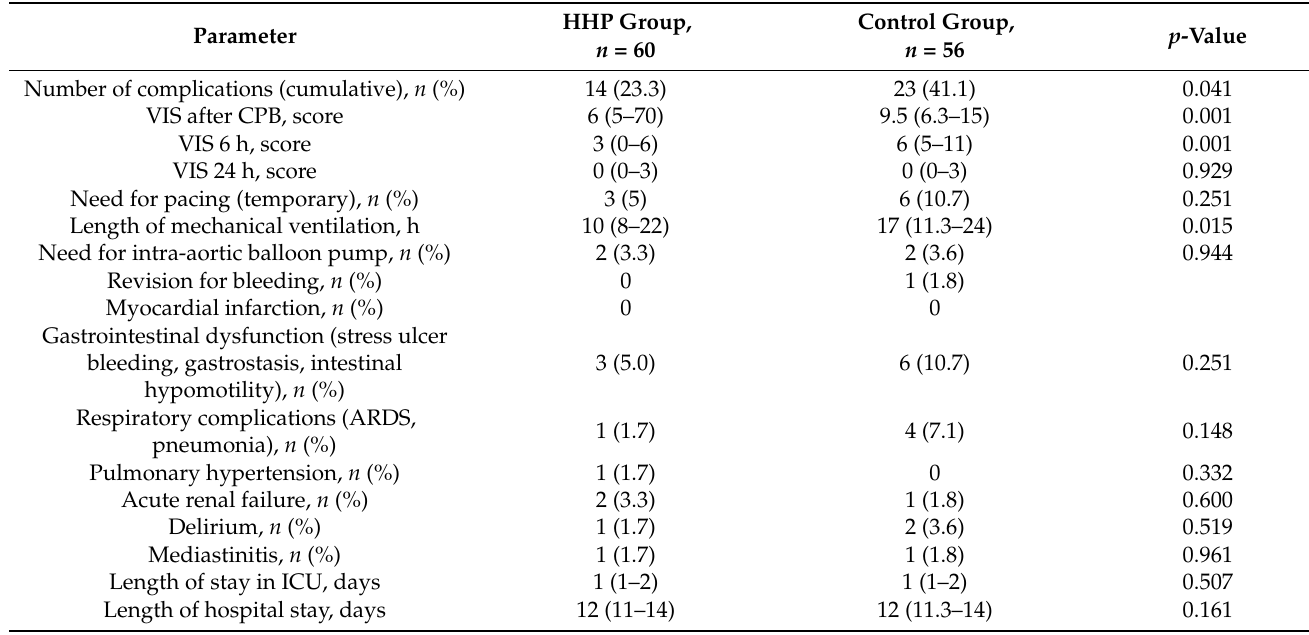
Table 6. Characteristics of the postoperative period.